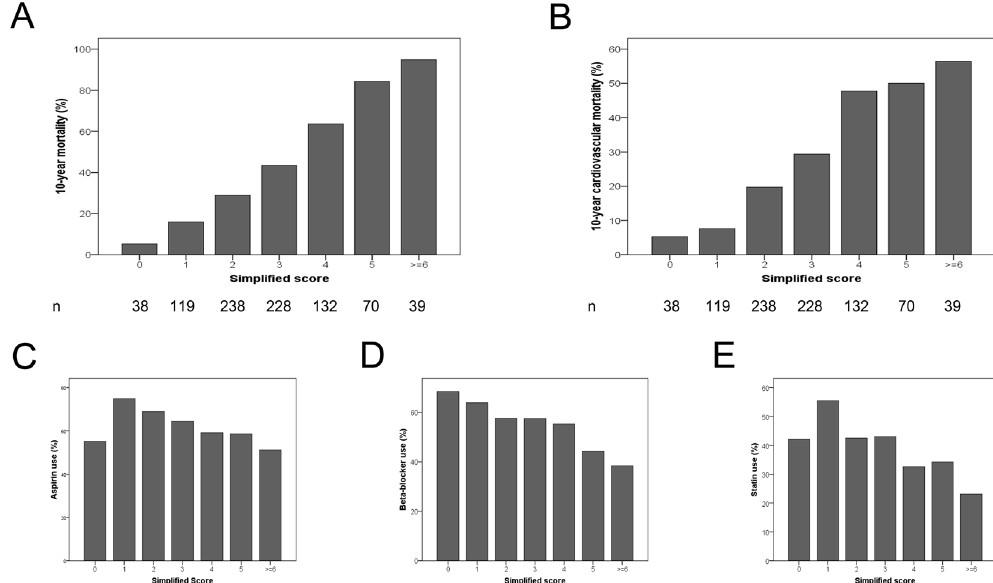
Figure 3. Risk prediction of simplified risk score and association with established cardiovascular medication. The bars show 10-year all-cause ( 3A ) and cardiovascular ( 3B ) mortality stratified by the simplified biomarker score. We further found an inverse associations between the simplified risk and aspirin use (for trend, p < 0.007, Fig. 3C), beta blocker use (for trend, p < 0.001, Fig. 3D) and statin use (for trend, p < 0.001, Fig. 3E) at discharge. The simplified score was based on the following cut-off values: [male = 1] + [age ≥ 75years (86